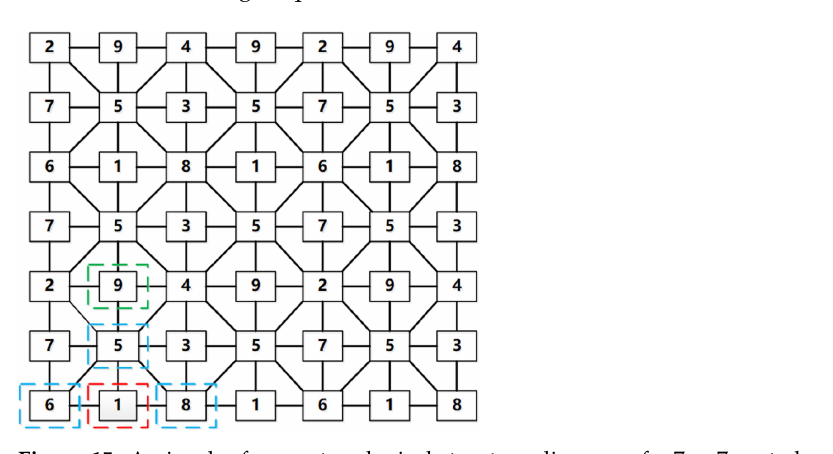
Figure 15. A visual reference topological structure diagram of a 7 × 7 nested magic square UAV formation.